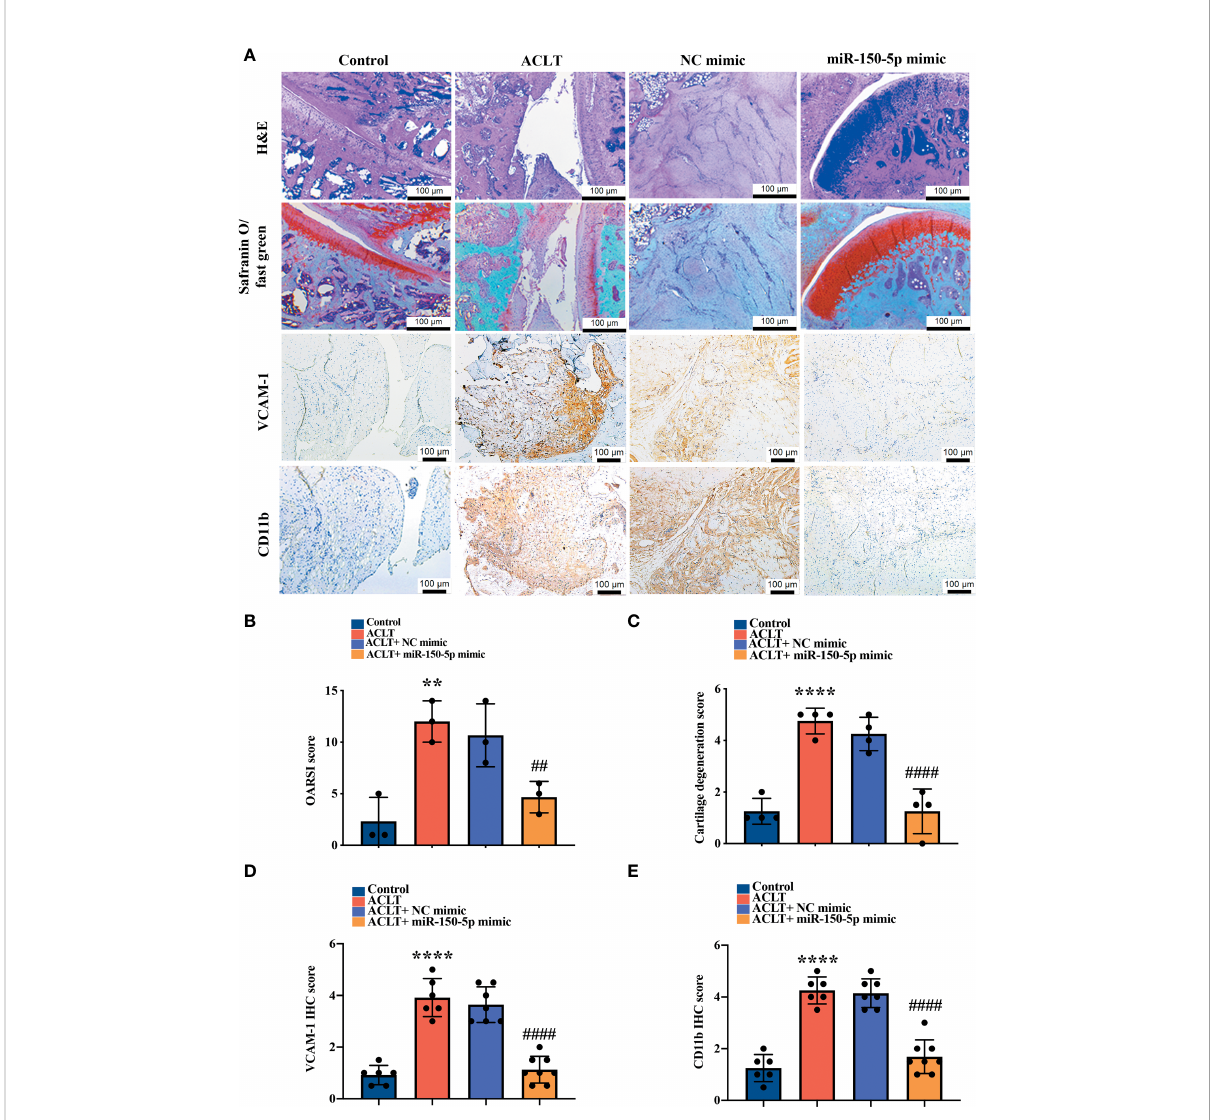
FIGURE 7 Histopathological evidence reveals that miR-150-5p ameliorates OA progression. (A) Specimens from the four groups were immunostained with H&E in four independent experiments, Safranin-O (four independent experiments), VCAM-1 (six independent experiments), or CD11b (six independent experiments). (B) OARSI scores were evaluated in three independent experiments and (C) cartilage degeneration scores were evaluated in four independent experiments. (D, E) IHC staining intensity was scored as absent (no staining, score 0), weak (1 – 20% staining, score 1), weak-moderate (21 – 40%, score 2), moderate (41 – 60%, score 3), moderate intensity (61 – 80%, score 4) and strong (81 – 100%, score 5). IHC staining data were scored in six independent experiments for both VCAM-1 and CD11b expression. ** p < 0.01, **** p < 0.0001 compared with Controls; ## p < 0.01, #### p < 0.0001 compared with ACLT